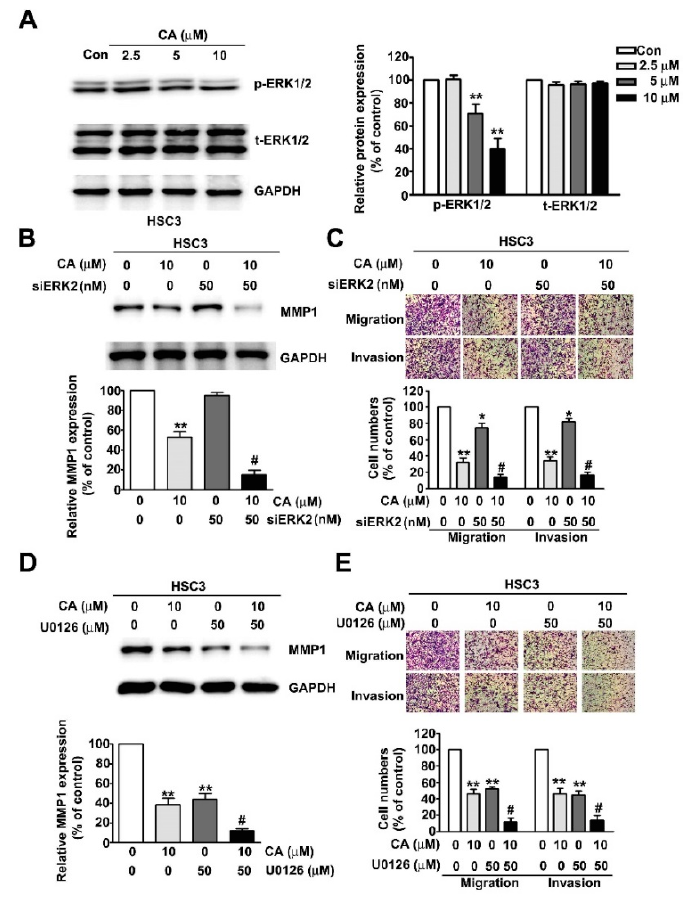
Figure 5. ERK1/2 pathway participation in CA-downregulated MMP1 expression, cell migration and invasion in human HSC3 cells. ( A ) Human HSC3 cells were treated with various concentrations of CA (0, 2.5, 5 or 10 µ M), after which phospho-ERK1/2 and total-ERK1/2 protein levels were measured via immunoblotting analysis. ( B , C ) Human HSC3 cells were treated with CA (10 µ M), siERK2 (50 nM) or CA (10 µ M) plus siERK2 (50 nM); and then MMP1 protein level, migration and invasion were further measured. ( D , E ) Human HSC3 cells were treated with CA (10 µ M), U0126 (specific ERK1/2 inhibitor; 50 µ M) or CA (10 µ M) plus U0126 (50 µ M), following which MMP1 protein level, migration and invasion were further measured. GAPDH was used as a protein loading control. Control: untreated cells and scrambled siRNA-transfected cells (for siRNA transfection). *, p < 0.05; **, p < 0.01 versus control (line 1); #, p < 0.05 versus CA (line 2) or siERK2, U0126 (line 3) (Mean ± SE, n = 3). Control: untreated cells. Scale bars: 50 µ